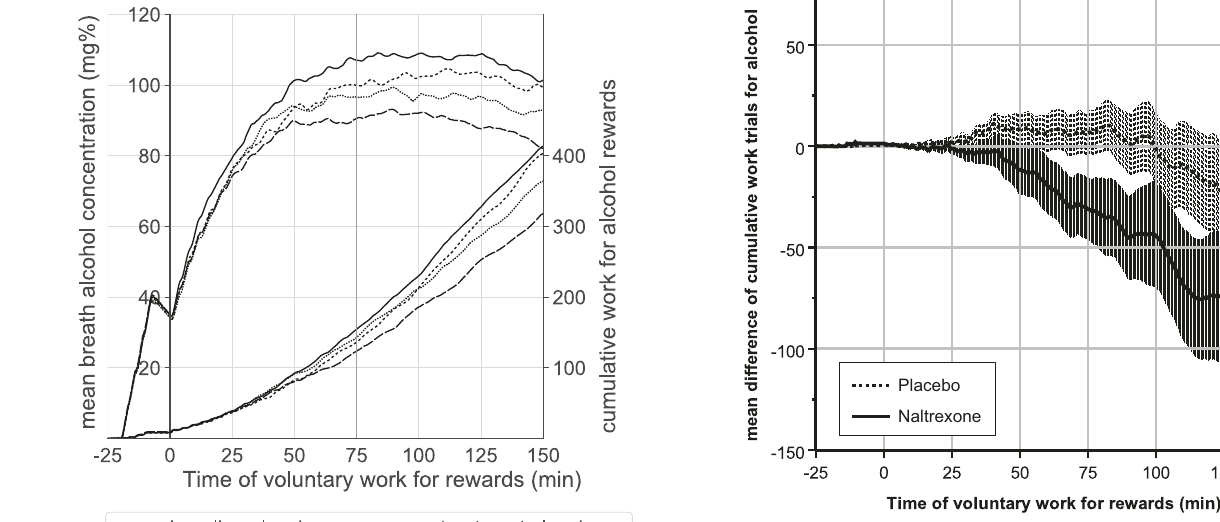
Fig. 4 Medication effect on cumulative work for alcohol over experimental time. Medication effect (difference between treat- ment and baseline) on cumulative work for alcohol over experi- mental time. Shaded areas = SEM. Note: 0 – 75 min = ascending phase of BrAC; 75 – 150 min = plateau phase of